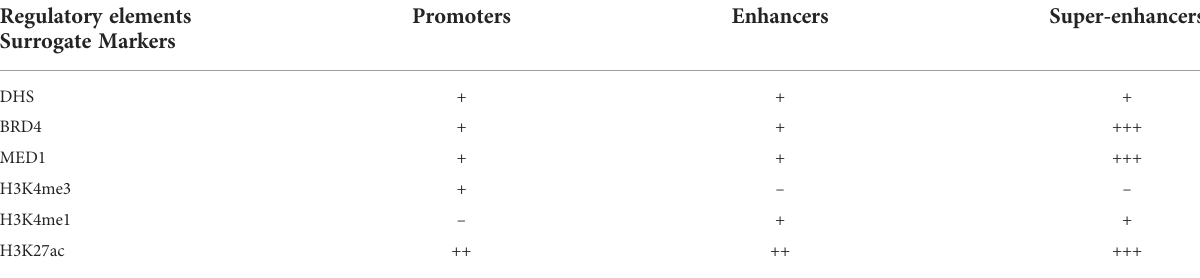
TABLE 1 Histone modi fi cation markers and the related functional state of the regulatory elements. Regulatory elements Surrogate